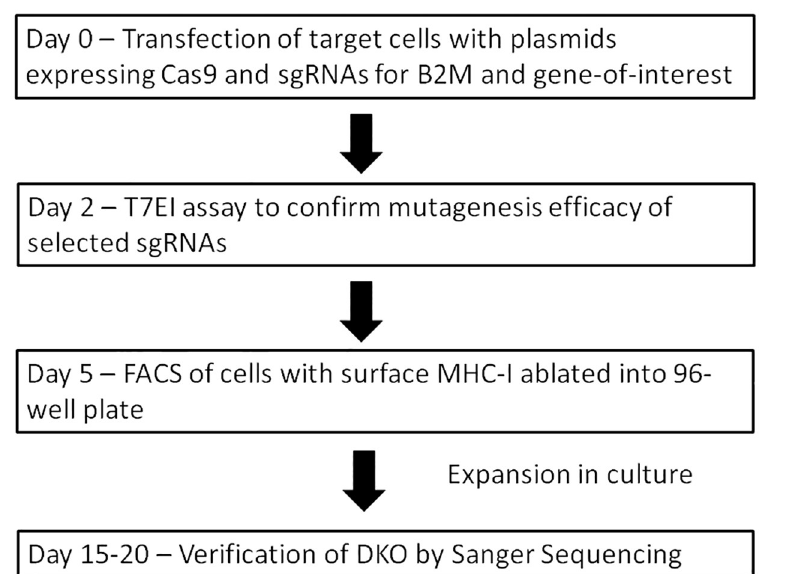
Fig 2. Workflow for FAME. See text for detailed